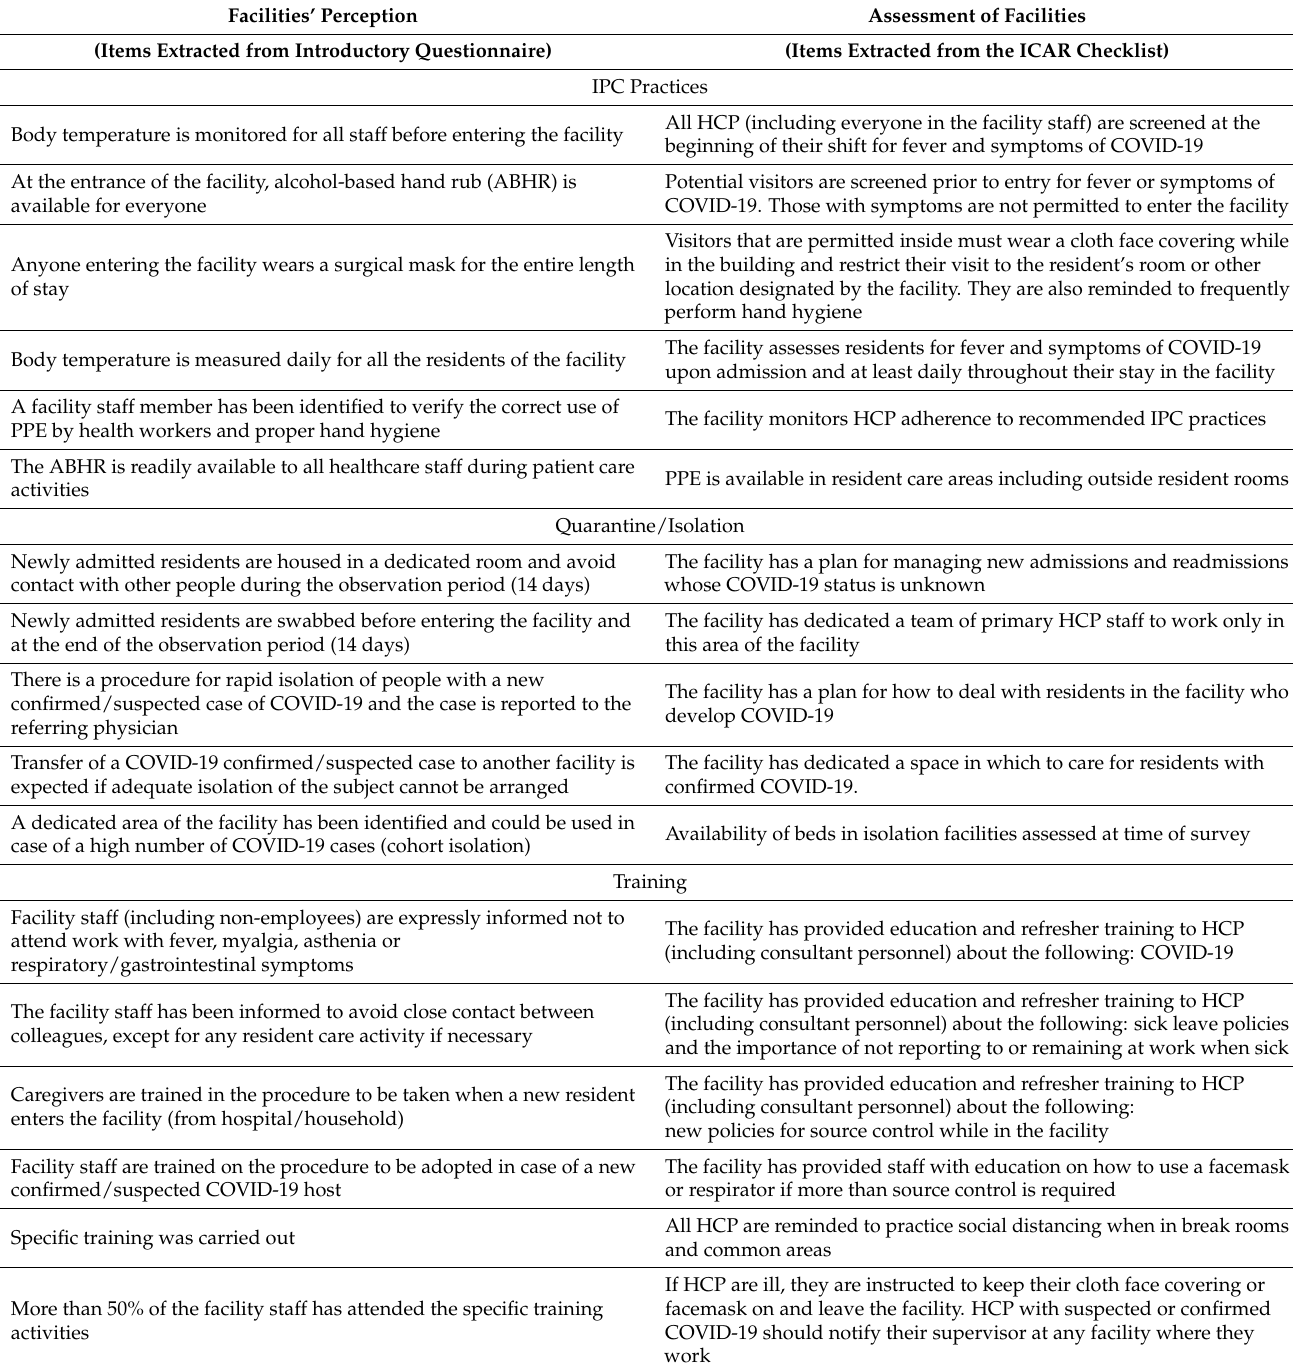
Table 2. Indicators of risk perception versus facilities hazard assessment (each item was given one point if